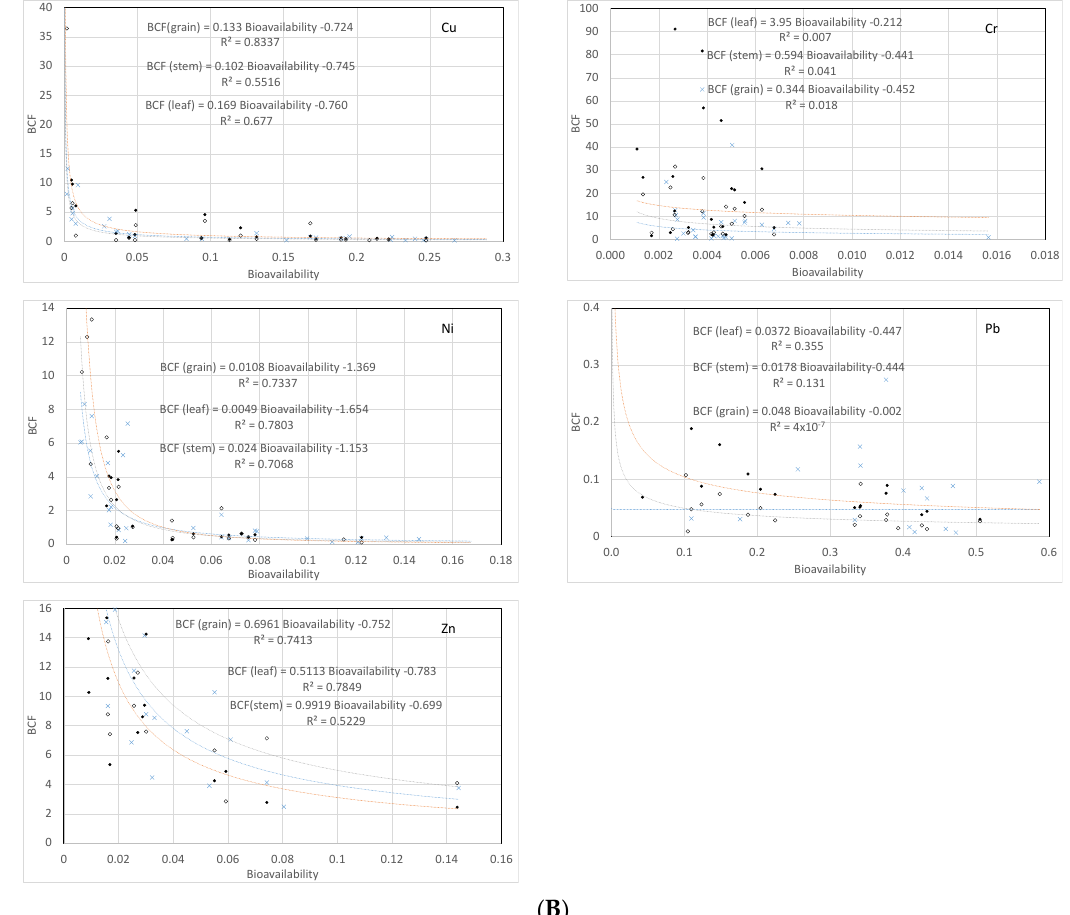
Figure 2. ( A ) Metal fraction diagram. ( B ) Relationship between bioconcentration in rice plants and bioavailability for the selected metals.